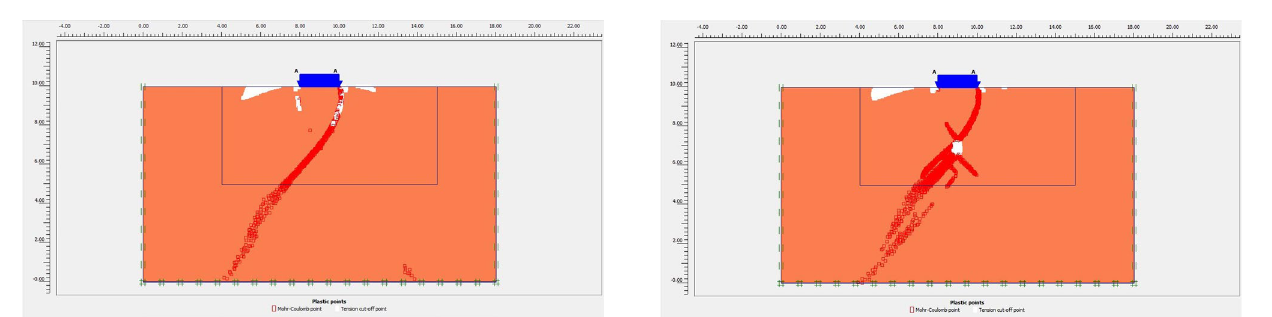
Fig. 28 Plastic points changes for the failed soil with 9% gasoline